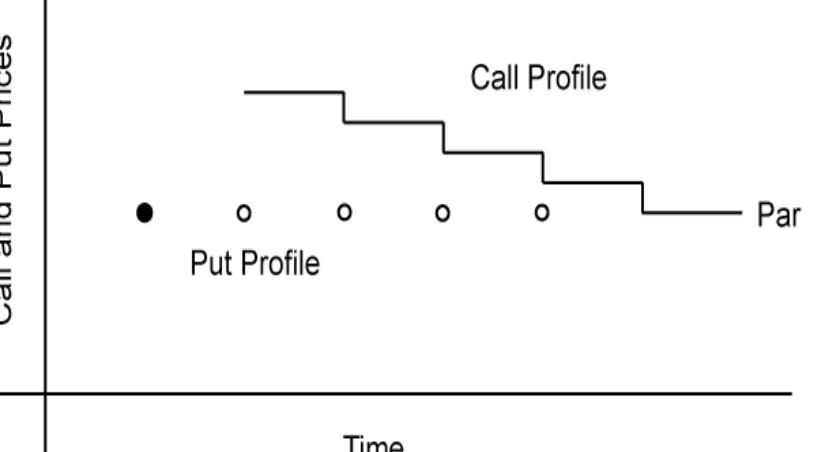
Figure 1. Schematic representation of call and put profiles of sample issues. The call profile is stepwise and continuous; the put profile is discontinuous and active either once (solid dot) or at a periodic interval (open dots).